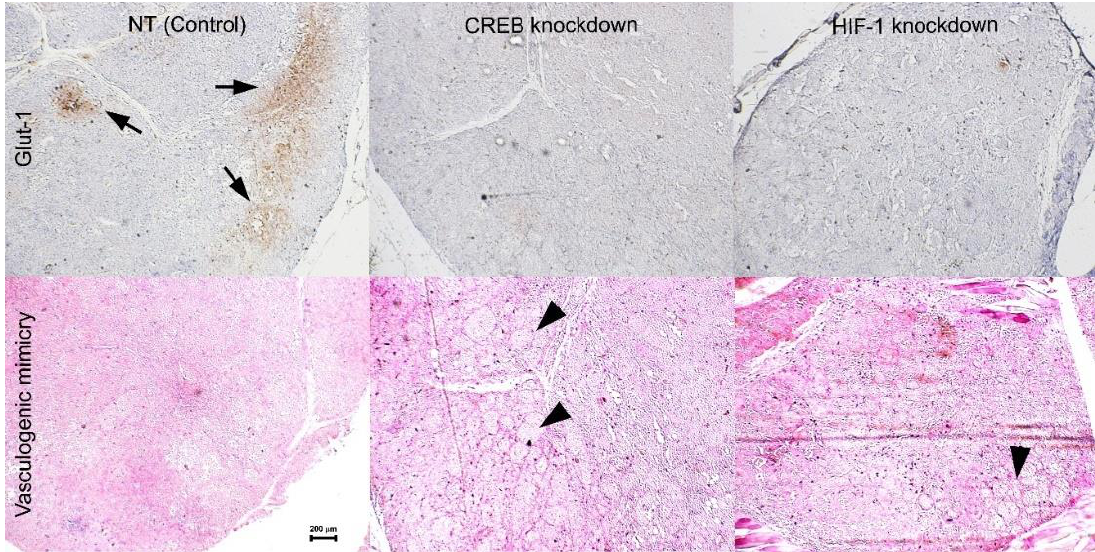
Figure 7. Histopathological analysis. Uveal melanoma tumors excised on day 35 (Figure 5) were processed for routine histopathology and serial sections were stained with H & E, anti-CD34, anti-Glut-1, and with PAS without hematoxylin (to highlight vasculogenic mimicry). Analysis of histopathological stains on five tumors per group (see Figure 6) was carried out by three independent viewers (magnification ×4, scale bar 200 microns).